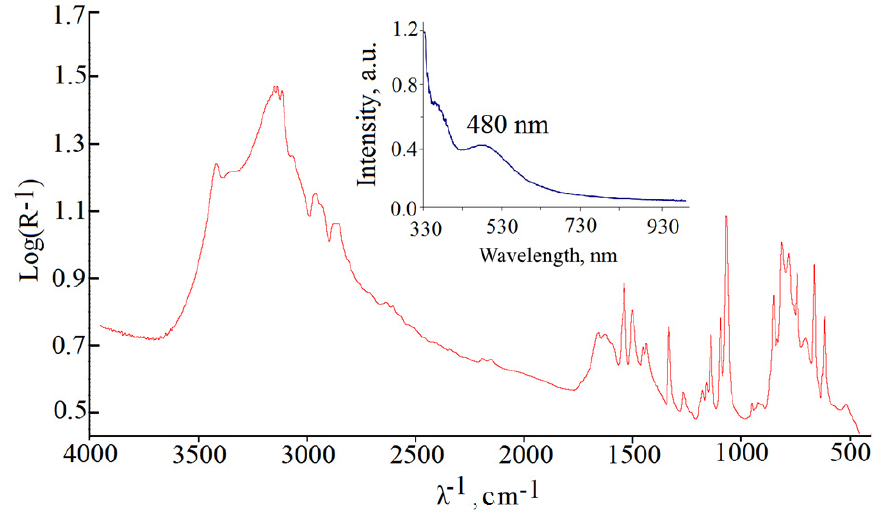
Figure 10. IR spectrum of compound II , inset: UV-vis spectroscopy of a methanolic solution of compound II .